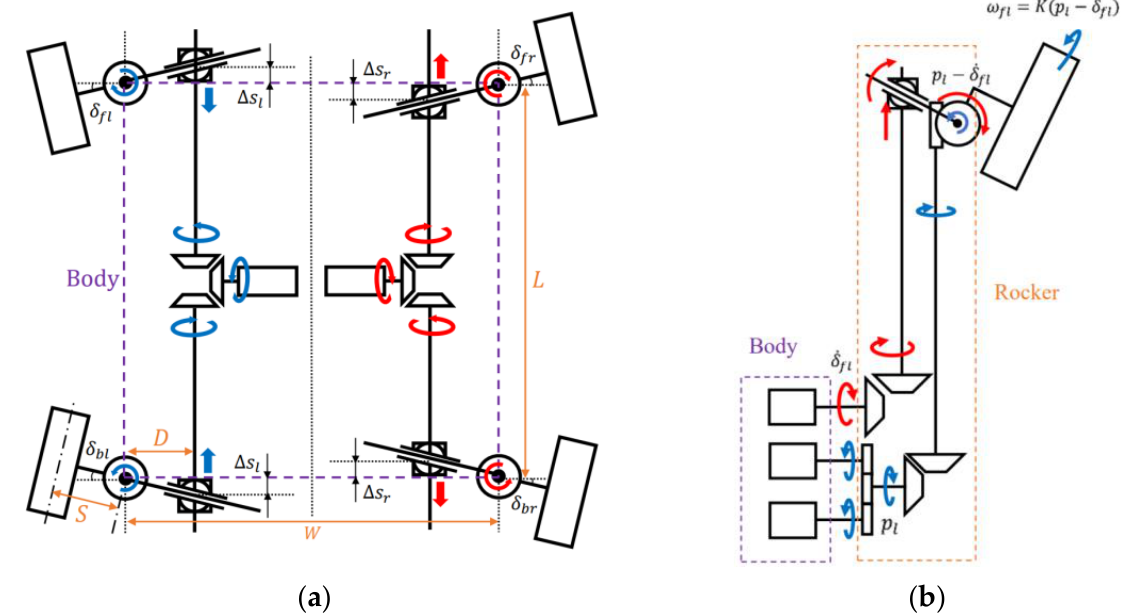
Figure 5. Illustrations of approximated kinematics modeling under the non-slip condition. ( a ) Modified explicit-steering mechanism. ( b ) Dual-motor driving mechanism.